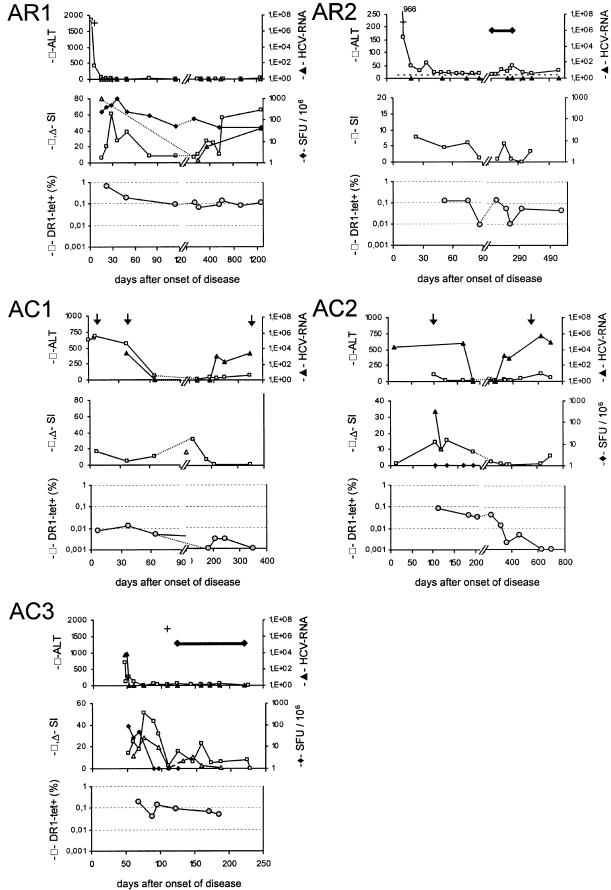
Clinical course of acute hepatitis C cohort in correlation to HCV specific CD4+ T cell response.The clinical course of each individual is shown in the upper panel in each case. Note the time scale (days) is different in each case. The upper panel shows the ALT (IU/L; open boxes; left hand y axis) and the serum HCV RNA level (closed triangles; right hand y axis). For AR1, AR2 and AC3, at some time points only qualitative assays for HCV-RNA were available which have been marked with a +. Interferon alpha therapy is marked with a bar. In patients AC1 and AC2 time points where the sequence of epitope 1806-1818 was determined are indicated by arrows. The middle panel in each case corresponds to functional CD4+ T cell assays: proliferation in response to NS3/4-antigen (open boxes) and peptide-1806-1818 (open triangles) is shown as stimulation index (SI) on the left hand y axis and HCV-antigen induced interferon-gamma secretion as determined by Elispot (solid diamonds) is shown as spot forming units (SFU) on the right y-axis. The lower panel of each case shows the frequency of HLA-DR1-HCV-1806-1818 tetramer positive CD4+ T cells (grey circles). The cut-off for detection was 0.001%. The upper limit of normal for ALT is indicated in panel AR2 as dotted line.